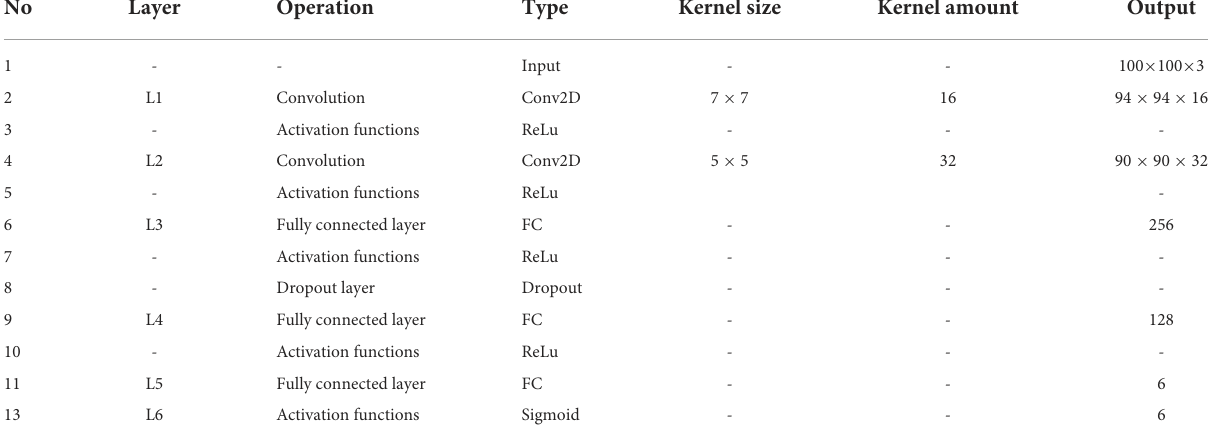
TABLE 1 The full parameters of the adopted CNN